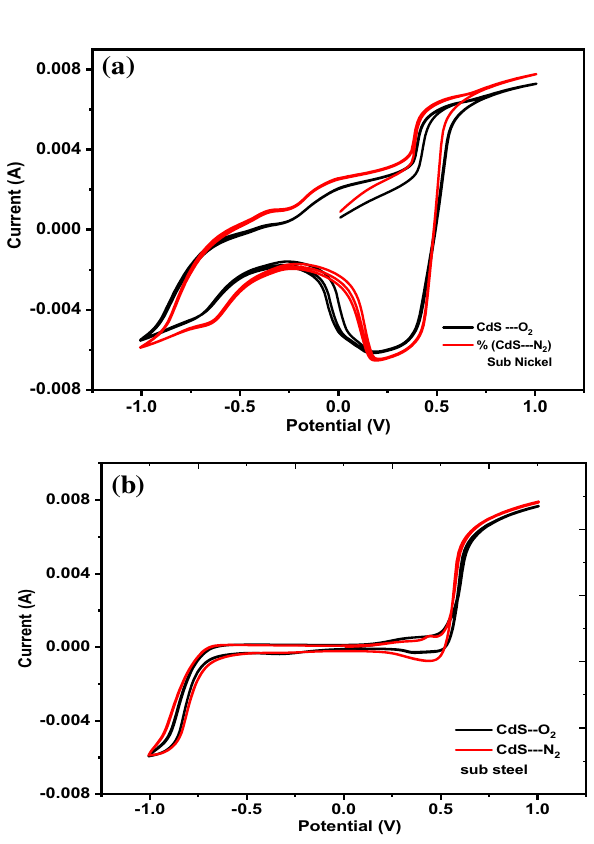
Fig. 8 Plot of thermal gravimetric analysis, TGA of the prepared CdS sample